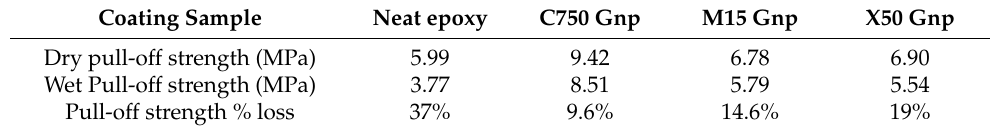
Table 2. Pull-off test results for Gnps/epoxy coatings after 7 days exposure to 3.5% NaCl solution.